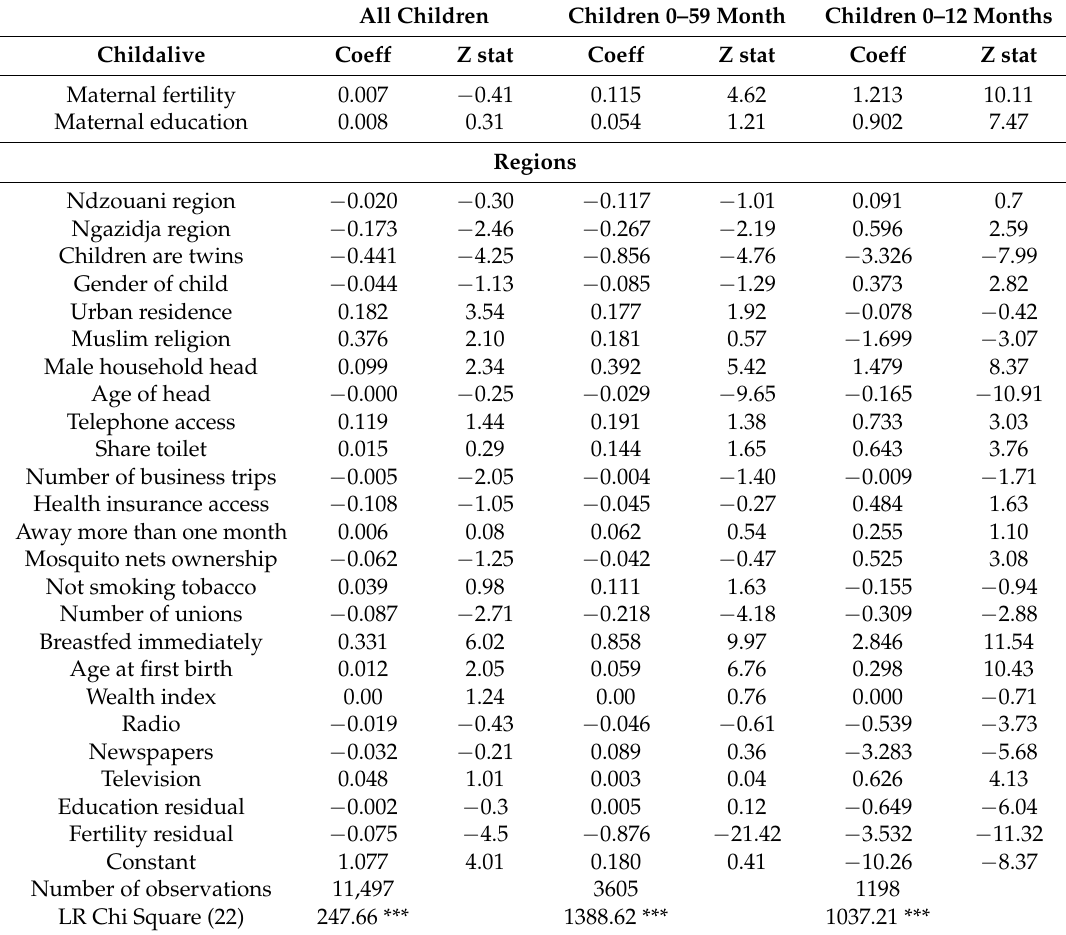
Table 4. Two Stage probit Regression for the Determinants of Child Survival in